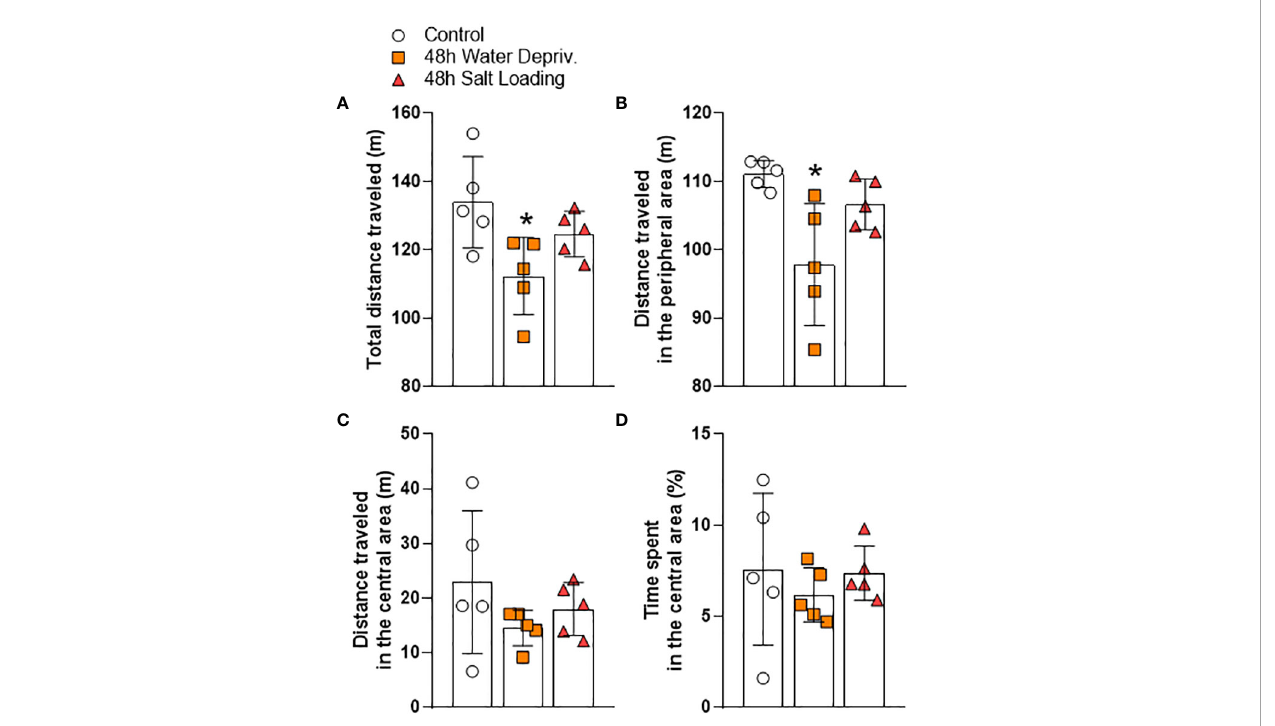
FIGURE 4 Effects of 48 h of dehydration in male adult rats on (A) total locomotion, (B) locomotion in the peripheral area, (C) locomotion in the central area, and (D) percentage the time spent in the central area during 10 min of evaluation in the open fi eld test. Values are mean ± SD of 5 animals per group. Data were submitted to one-way ANOVA followed by the Tukey post hoc test, except for the distance traveled in the peripheral area, in which the Kruskal- Wallis test was used, followed by Dunn ’ s post hoc test. *p<0.05 compared to the control